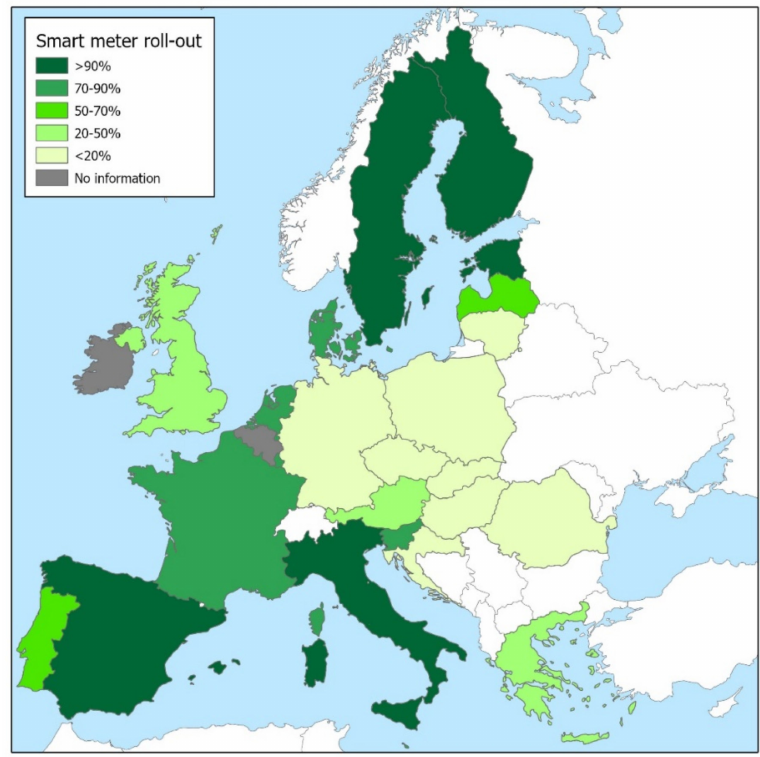
Figure 3. Progress on national smart meter